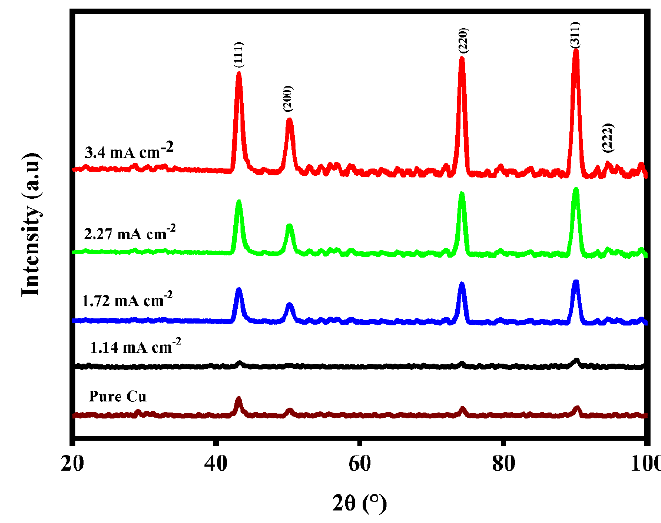
Figure 11. XRD patterns of ncCuAg.